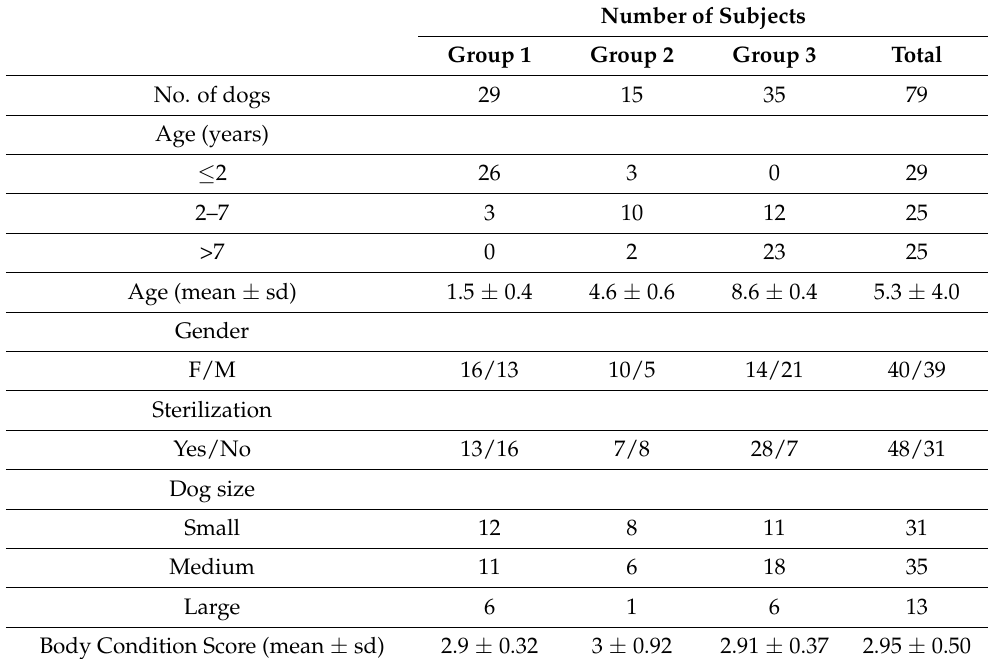
Table 3. Descriptive statistics of the population enrolled in the study according to grade of periodontal disease (Group 1, Group 2, Group 3).